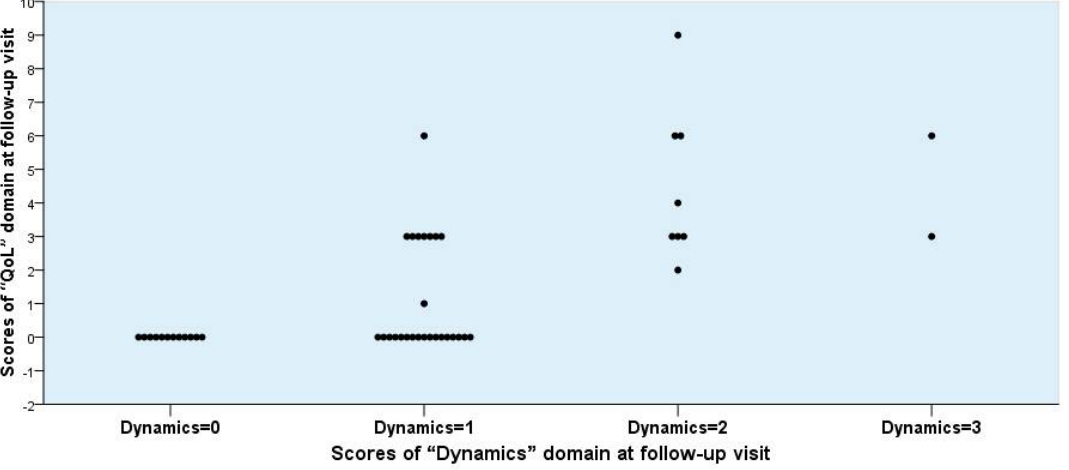
Figure 3. Individual scores for “Quality of Life (QoL)” versus “Dynamics” domain obtained from 48 female patients at the follow-up visit.